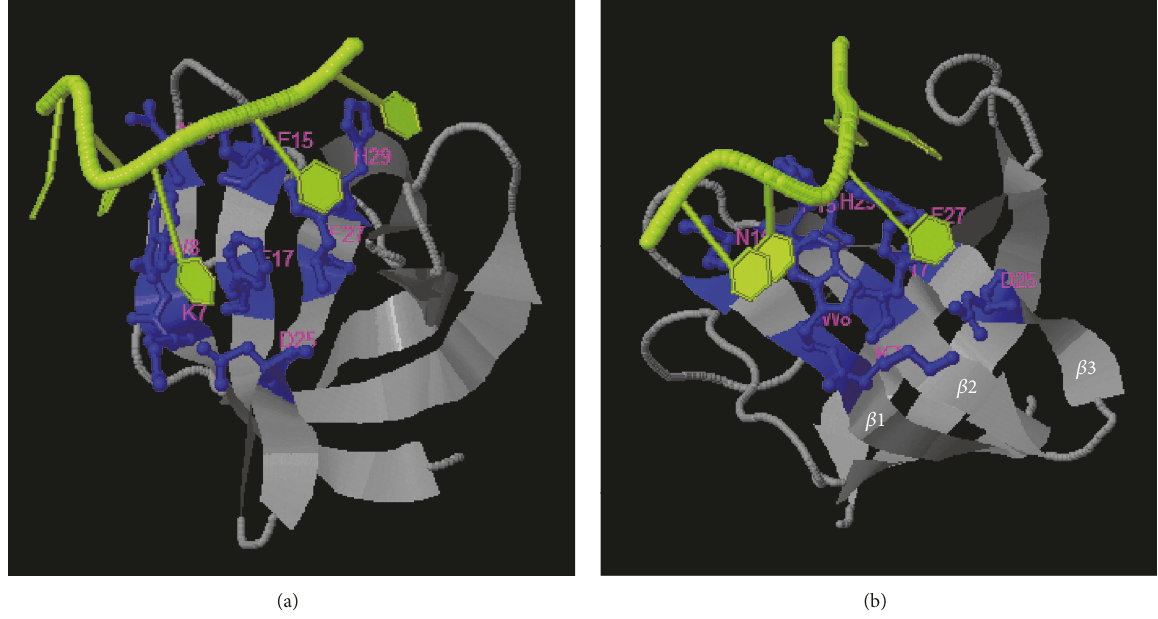
Figure 6: Functional site prediction of Dm-Csp1 . COACH output identifying N-terminally located residues predicted to bind single-stranded nucleic acids ((a), nucleic acid colored green, binding residues colored blue), and the same output repositioned to show the predicted nucleic acid binding residues is found within three anti-parallel beta-strands that collectively form a nucleic acid binding surface (b).